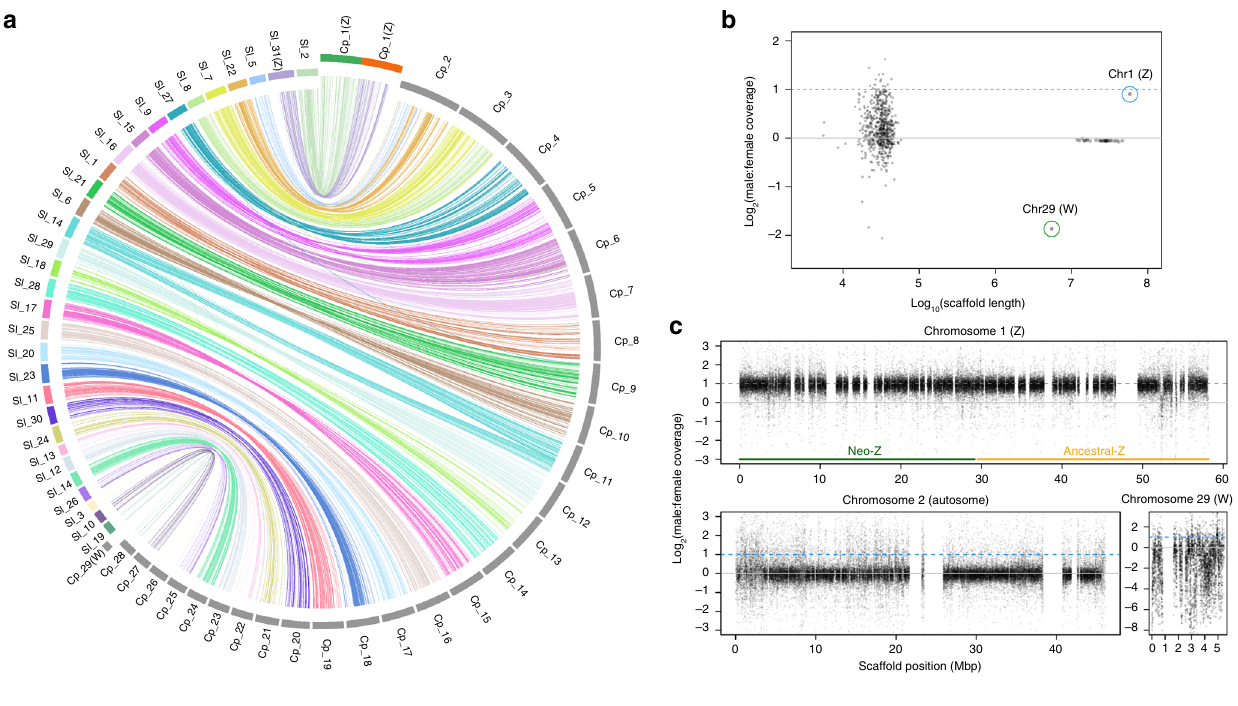
Fig. 2 Chromosomal identi fi cation and evolution of the codling moth, Cydia pomonella . a Comparative analysis of synteny between C. pomonella (Cpom) and Spodoptera litura (Slit) chromosomes. b Male:female coverage ratios for each scaffold, plotted by scaffold length. Each point represents a single scaffold. The solid gray line is the theoretical expectation for autosomes and the dotted blue line shows the expectation for the Z chromosome. c Male:female coverage ratios plotted in 500 bp windows across scaffolds for Z, W, and a representative autosome (Chr 2). Line colors as described in ( b